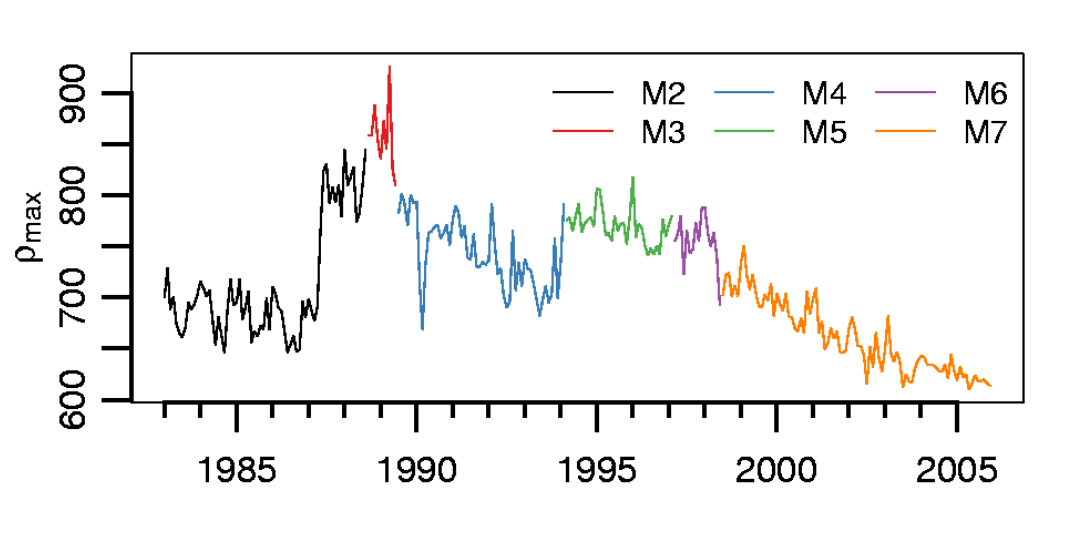
Figure 2. Temporal evolution of ρ for the MVIRI period from 1983 to 2005. The max Meteosat satellites (Meteosat 1–7) are illustrated in different